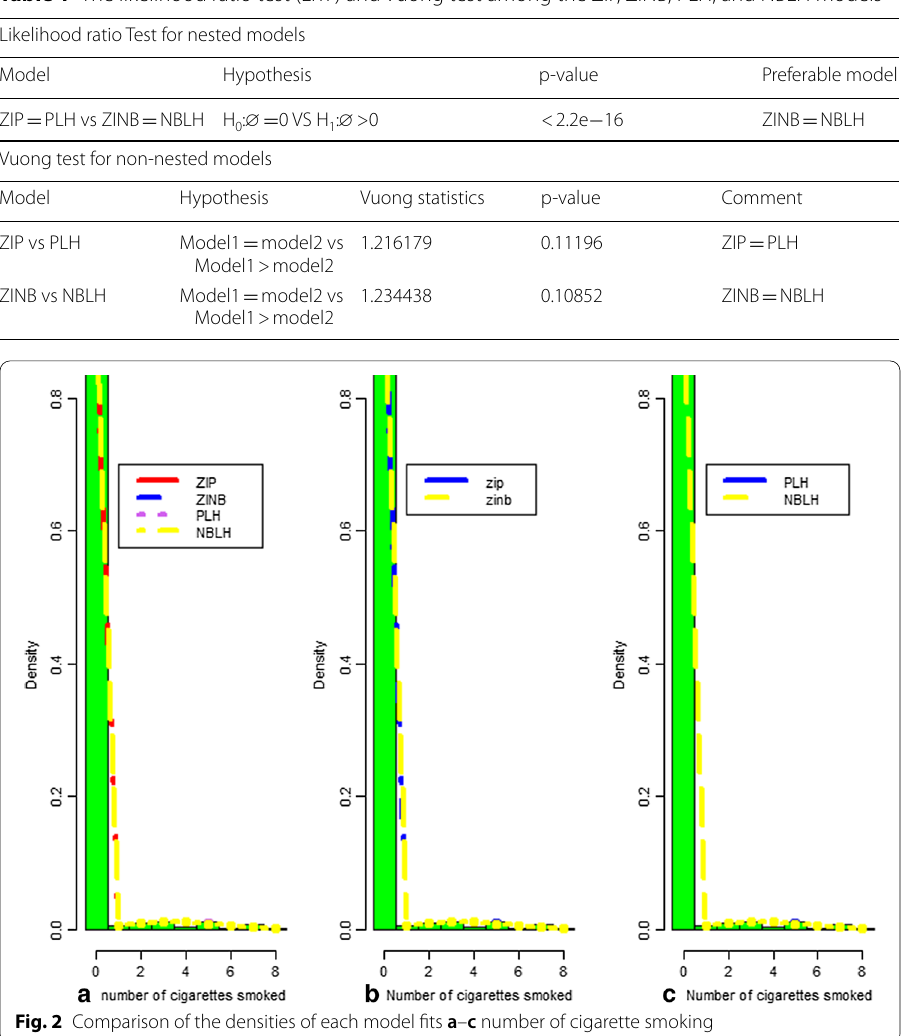
Fig. 2 Comparison of the densities of each model fits a – c number of cigarette